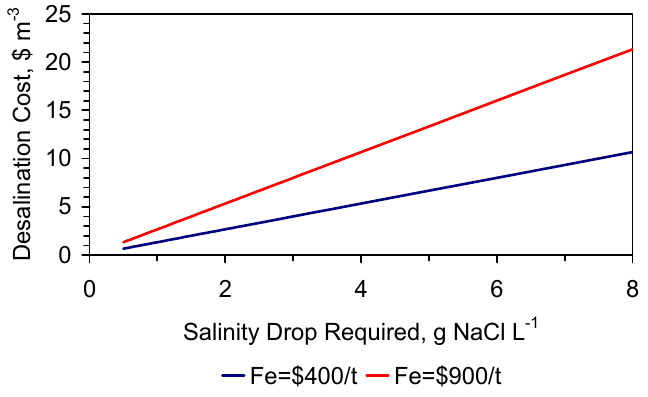
Figure 17. Desalination cost using ZVM TP, assuming no residual value for the ZVM TP and no reuse of the ZVM TP. P w of 20 g·L − 1 , and Q e = 300 mg·g − 1 .